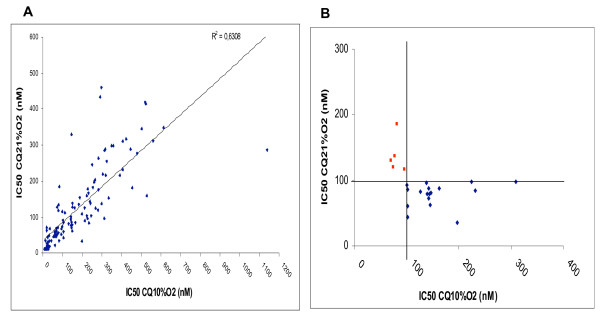
Chemosusceptibility of Plasmodium falciparum isolates to chloroquine under 10% O2 and 21% O2. A: chloroquine IC50 of 120 isolates. B: red plots corresponds to isolates with a switch from susceptible to chloroquine at 10% O2 to resistant at 21% O2; blue plots corresponds to isolates with a switch from resistant at 10% O2 to susceptible at 21% O2.